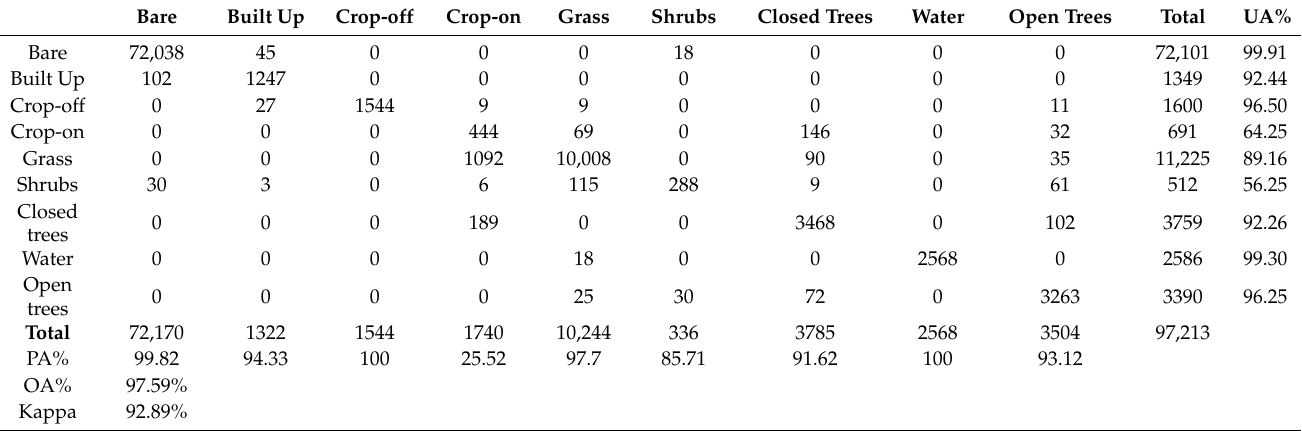
Table 3. Confusion classification matrix for the landscape classes in the Northern Kenya/Southern Ethiopia study region mapped using the Landsat 7 ETM+ composite images for 2011, and using random forest as a classifier.